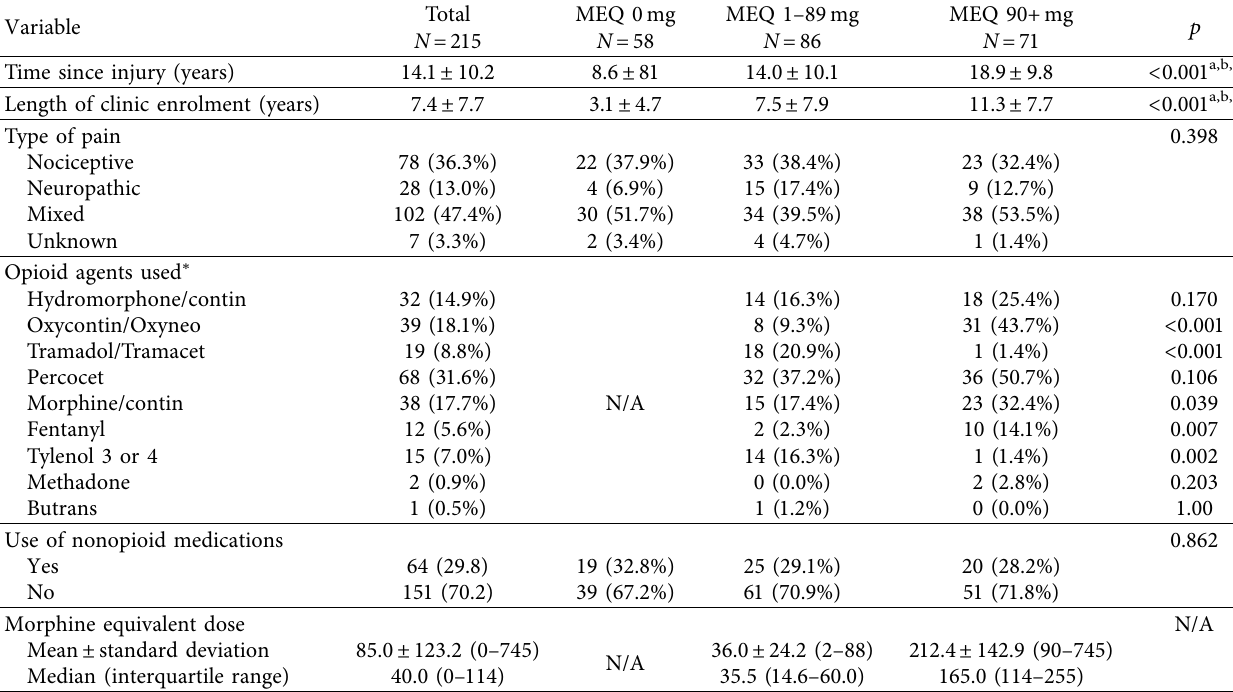
Table 2: Clinical health information and descriptive statistics for the total sample and three morphine equivalent groups.